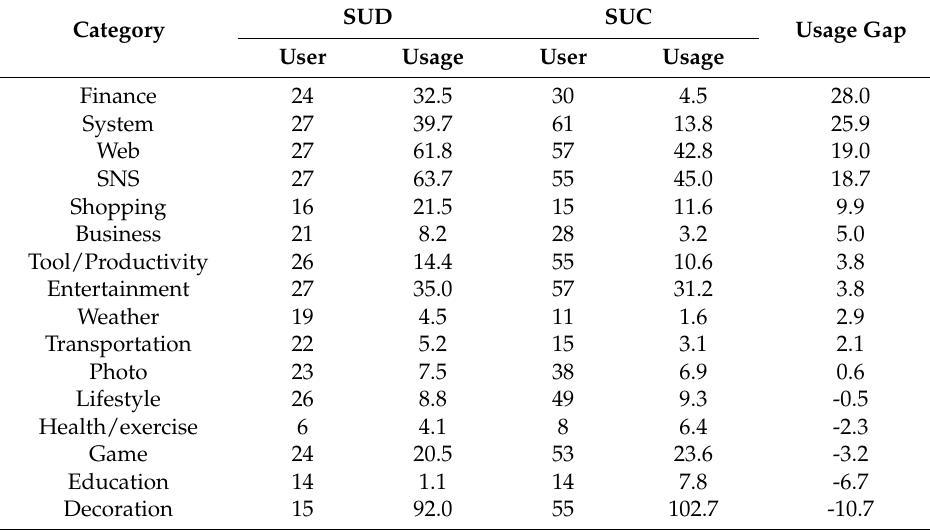
Table 3. Daily average usage by